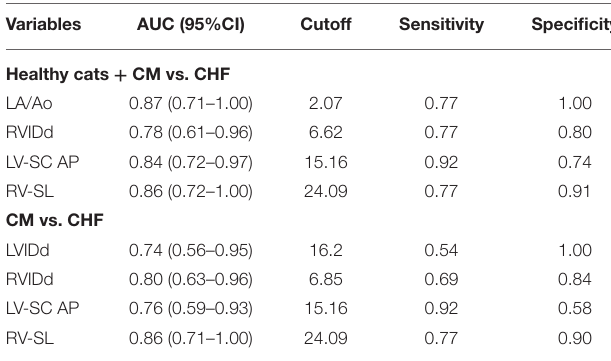
TABLE 4 | Results of receiver operating characteristic curves of the significant variables in the logistic regression analysis.